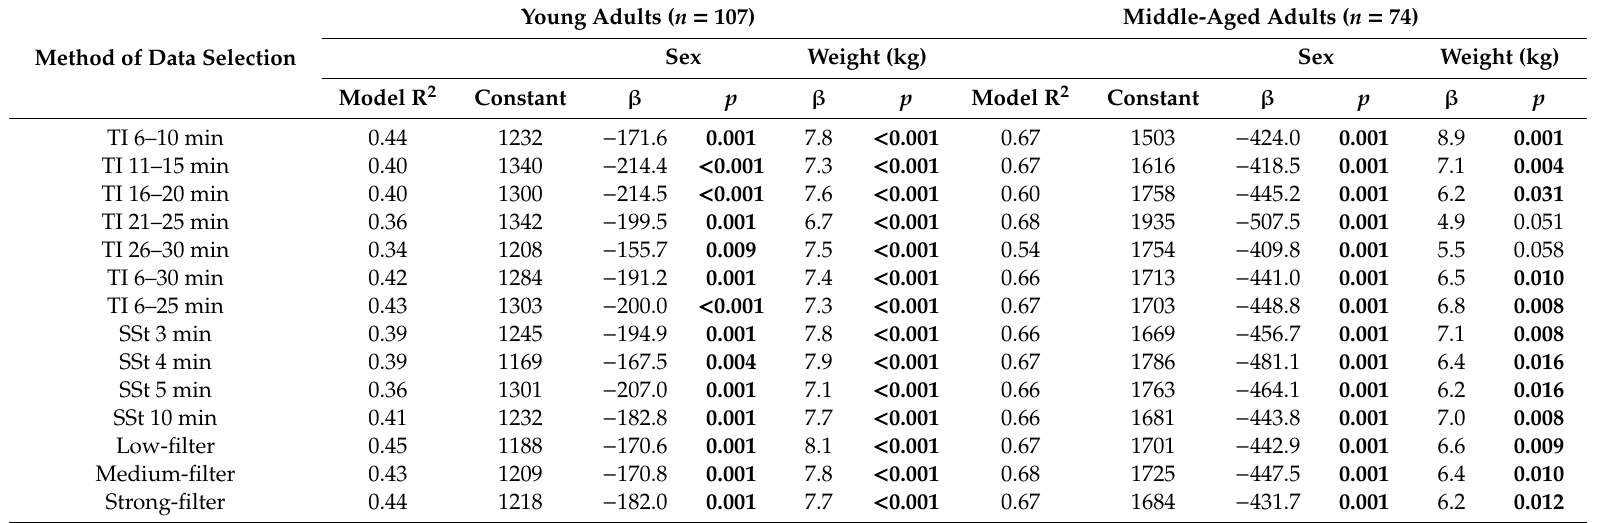
Table 2. Variance in resting metabolic rate (RMR) explained by sex and body weight in each of the gas exchange data selection methods.